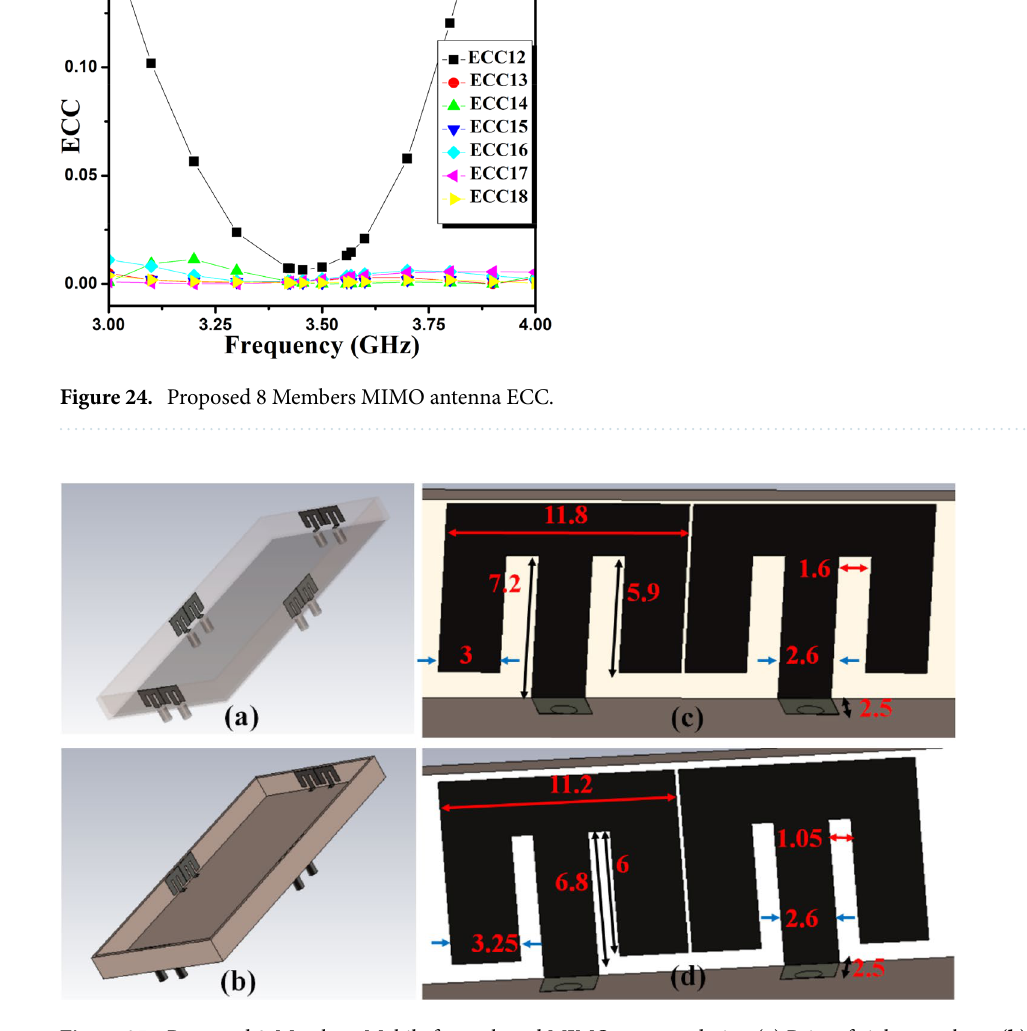
Figure 25. Proposed 8-Members Mobile frame-based MIMO antenna design ( a ) Pairs of eight members, ( b ) structure of mobile frame, ( c ) member one structure and dimension, ( d ) member five detailed structure (all dimensions are in mm).